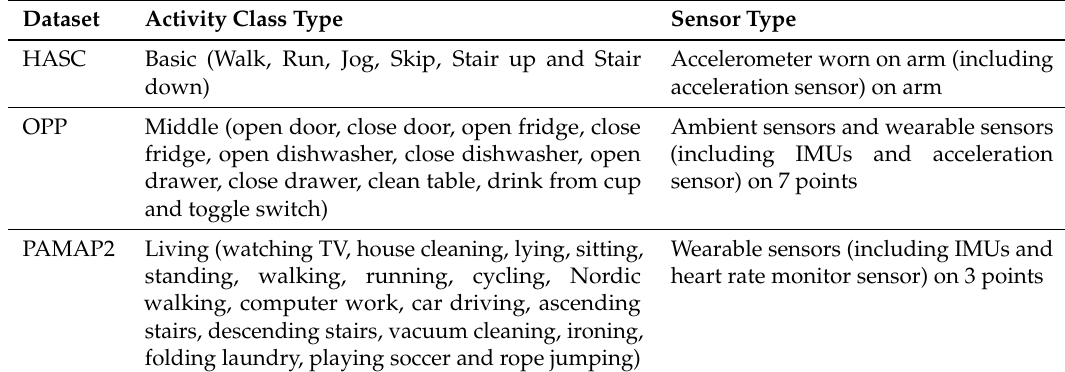
Table 1. Activity classes and sensor types of each dataset